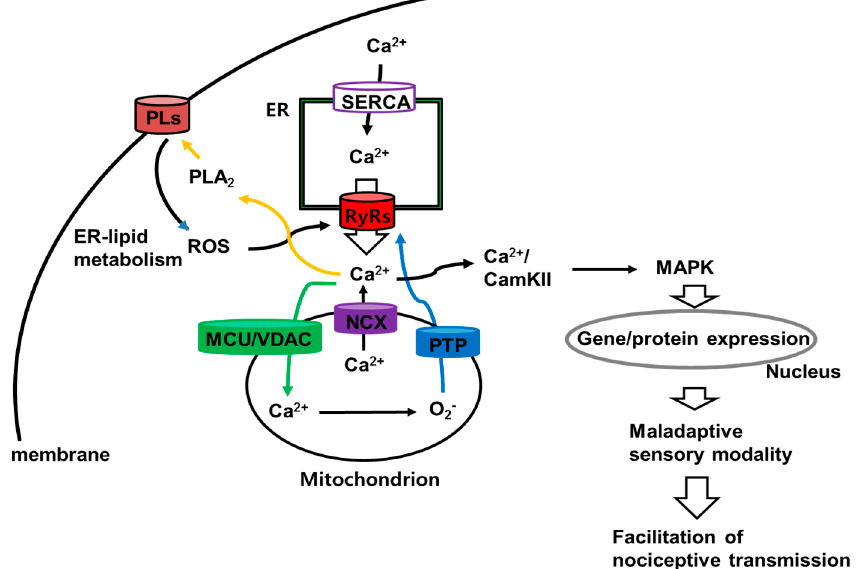
Figure 6. The schematic flow of ROS–CamKII interaction and facilitation of nociceptive transmission in SCI pain. The cytosolic calcium ions in ER are triggered by activation of sarco/endoplasmic reticulum Ca 2+ -ATP (SERCA). Activation of RyRs increase calcium ion efflux into cytoplasm and initiates calcium-dependent processes. (1) Calcium ions trigger the activation of calcium-dependent phospholipase A 2 (PLA 2 ) to cause the production of ROS via breakdown of membrane phospholipid (PLs, ER-lipid metabolism). (2) Following the activation of mitochondrial calcium uniporter/voltage-dependent anion channel (MCU/VDAC), mitochondrial calcium ions generate superoxide via mitochondrial respiratory chain complexes. Outflux of superoxide via permeability transition pore (PTP) in mitochondria activates ryanodine receptors (RyRs) in ER that result in increases of calcium ions outflux. (3) Mitochondrial calcium ions outflux via sodium/calcium exchanger (NCX) increase cytosolic calcium ions. (4) Calcium/CamKII-mediated activation of mitogen activates protein kinase family (p38MAPK, ERK, and Jun) that initiates the gene/protein expression, which is result in the facilitation of excitatory nociceptive transmission.